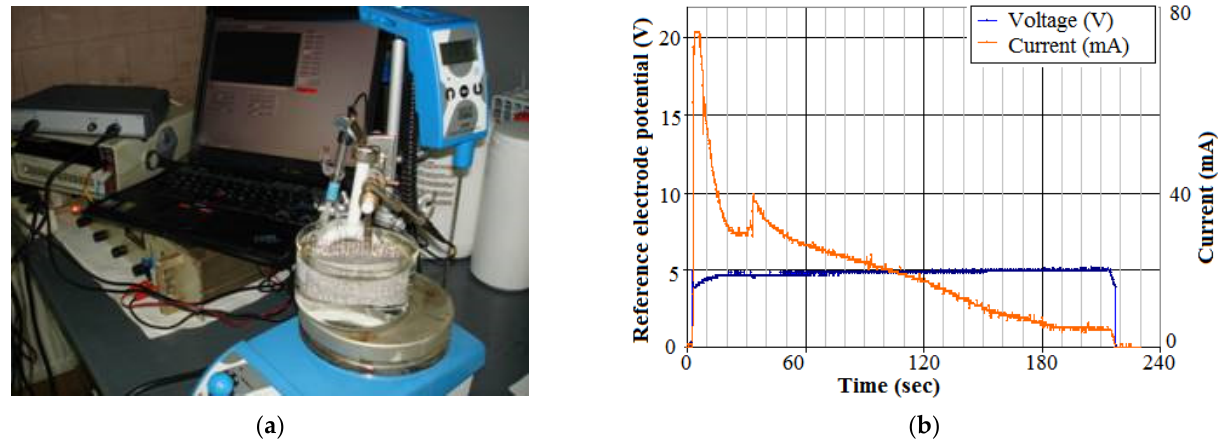
Figure 2. ( a ) The electrochemical combine used for the Ti-film conversion in nanostructured TiO 2 , and ( b ) potential of the reference electrode and current during anodization.